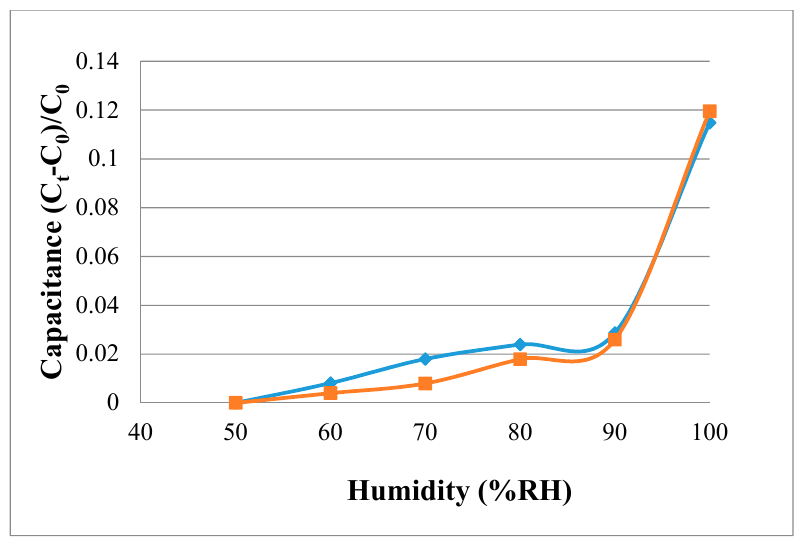
Figure 9. Calibration curves of the micro humidity sensors.